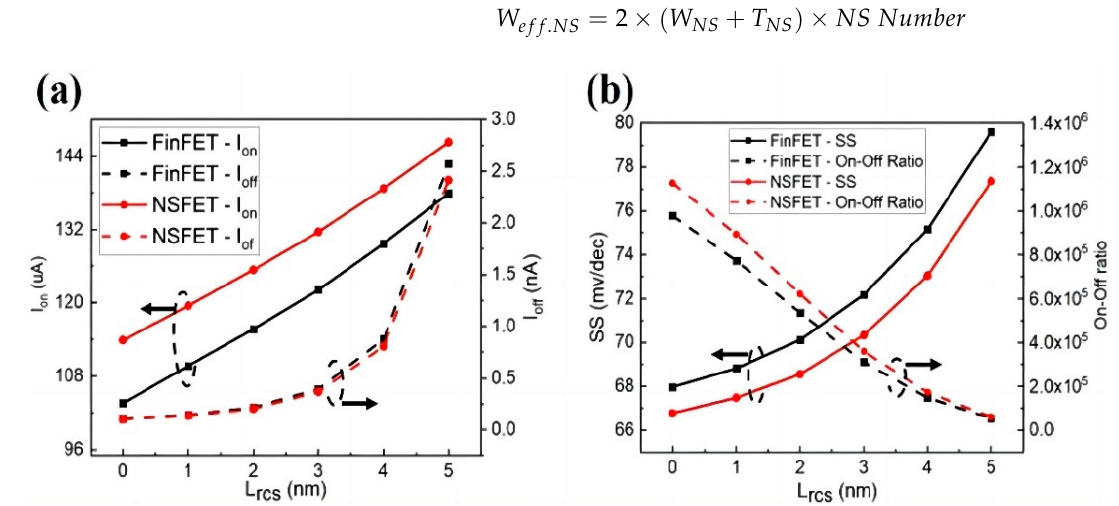
Figure 4. Trends of DC characteristics by L rcs variations ( a ) I on and I off , ( b ) SS and On-Off ratio.